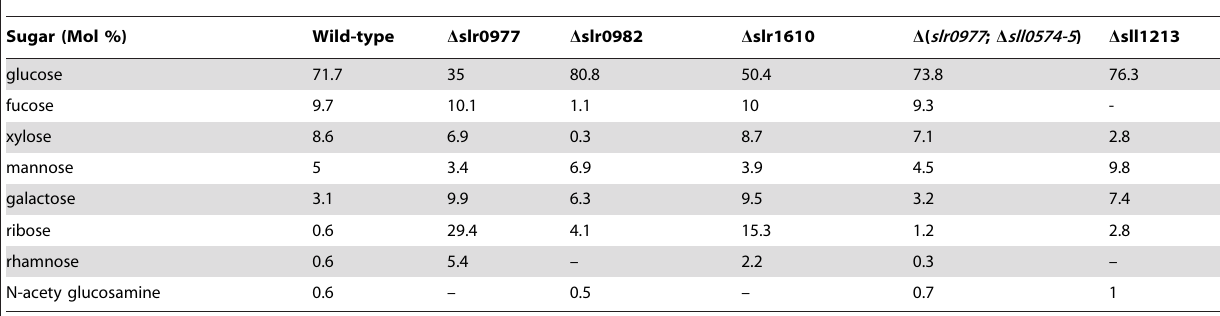
Table 5. Gas chromatographic analysis of EPS components a .